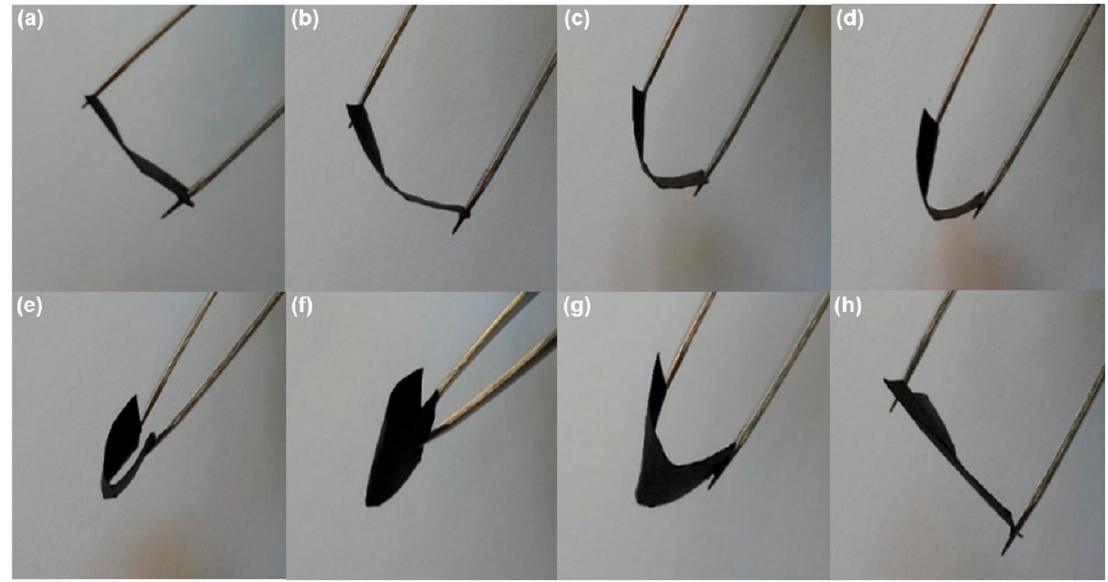
Figure 5. A series of photographs to illustrate the flexibility of the PEDOT:PSS/PPy/paper film. ( a ) Start to bend; ( b – e ) bending progress; ( f ) bended state; ( g ) releasing the bend; ( h ) returned to non-bended state as beginning.